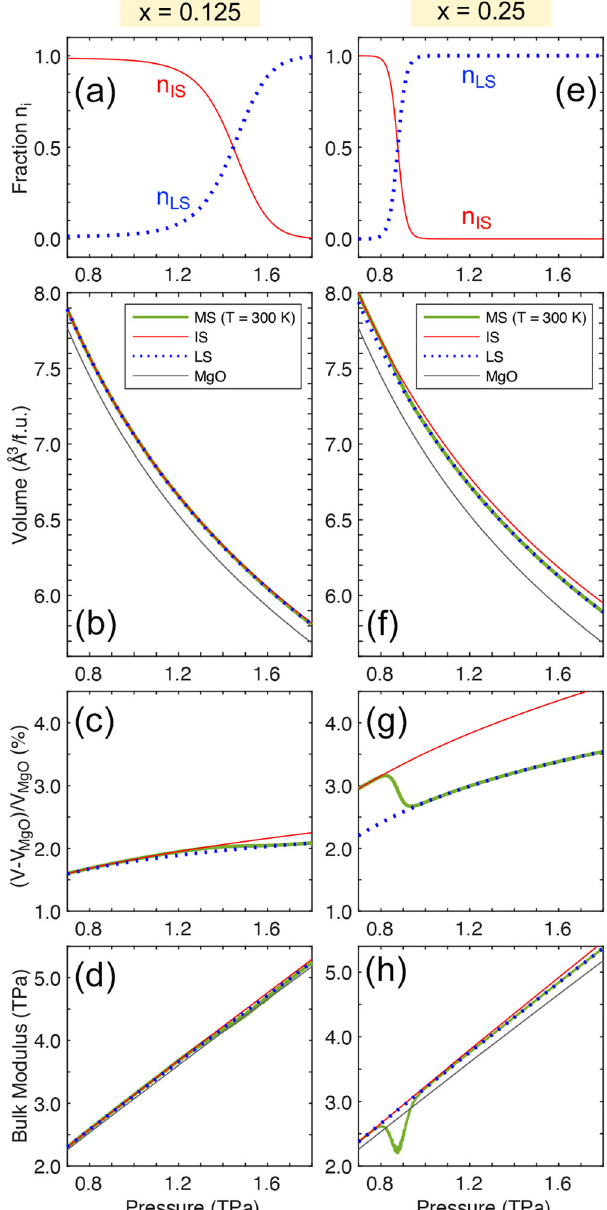
Fig. 7 Spin transition and accompanying volume/elastic anomalies of (r)B2 (Mg 1 − x Fe x )O at room temperature. a – d rB2 (Mg 0.875 Fe 0.125 )O; e – h B2 (Mg 0.75 Fe 0.25 )O. a , e Fractions of the intermediate-spin (IS) and low-spin (LS) states; b , f compression curves; c , g relative volume difference with respect to pure B2 MgO; d , h isothermal bulk